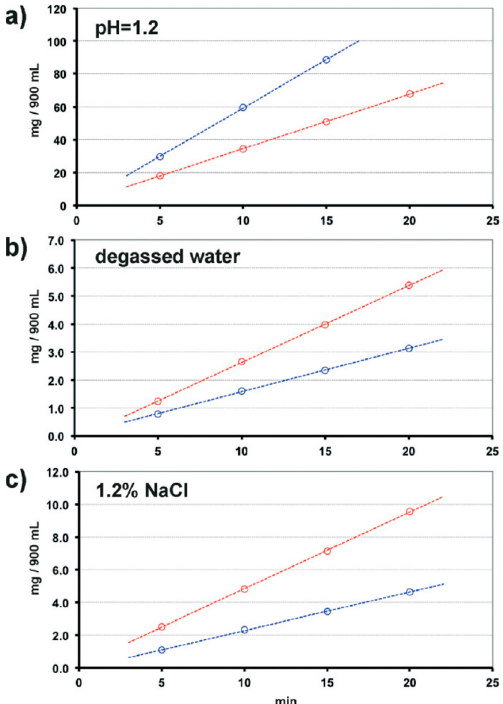
Figure 3. Dissolution rates of 1:1 sildenafil–acetylsalicylic acid cocrystal and sildenafil citrate in ( a ) an aqueous solution at a pH of 1.2, ( b ) degassed water, and ( c ) an aqueous solution containing 1.2% NaCl. Colour scheme: 1:1 cocrystal—blue, sildenafil citrate—red. Adapted with permission from CrystEngComm, 2014, 16, 32-35. Copyright 2014 The Royal Society of Chemistry.